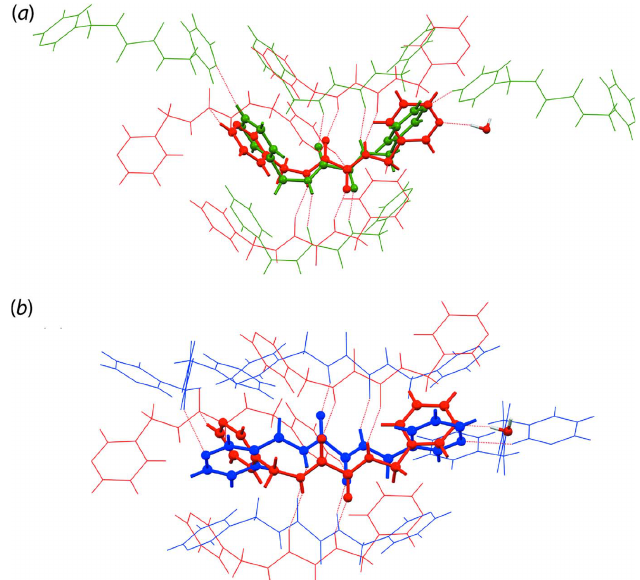
Figure 7 A comparison of the molecular packing of 3 L H 2 : ( a ) (I) (red) and Form I (green) and ( b ) (I) (red) and Form II (blue), showing the differences in terms of molecular connectivity of 3 L H 2 with r.m.s. deviations of 0.895 and 1.581 A˚ , respectively.